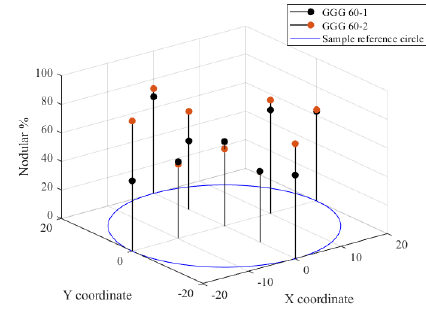
Figure 12. Graphite percentage in GGG60.